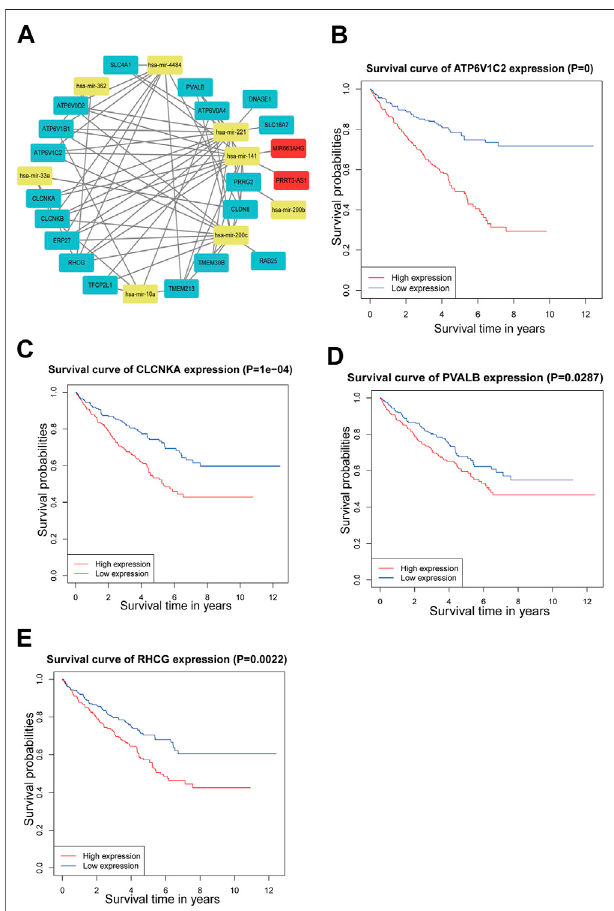
FIGURE 3 | ceRNA network and survival analysis. (A) ceRNA network based on the hub m6A-lncRNAs. There were two hub m6A-lncRNAs, eight DEmiRNAs, and 18 DEmRNAs in the ceRNA network. The red squares represent hub m6A-lnRNAs, yellow squares are miRNAs, and blue squares mean mRNAs. (B – E) The survival analysis for ATP6V1C2, CLCNKA, PVALB, and